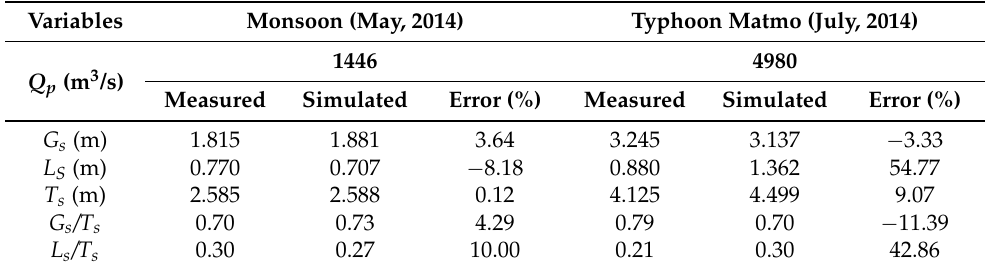
Table 3. Summary of measured scour depths and simulated results for Monsoon and Typhoon Matmo. Variables Monsoon (May,